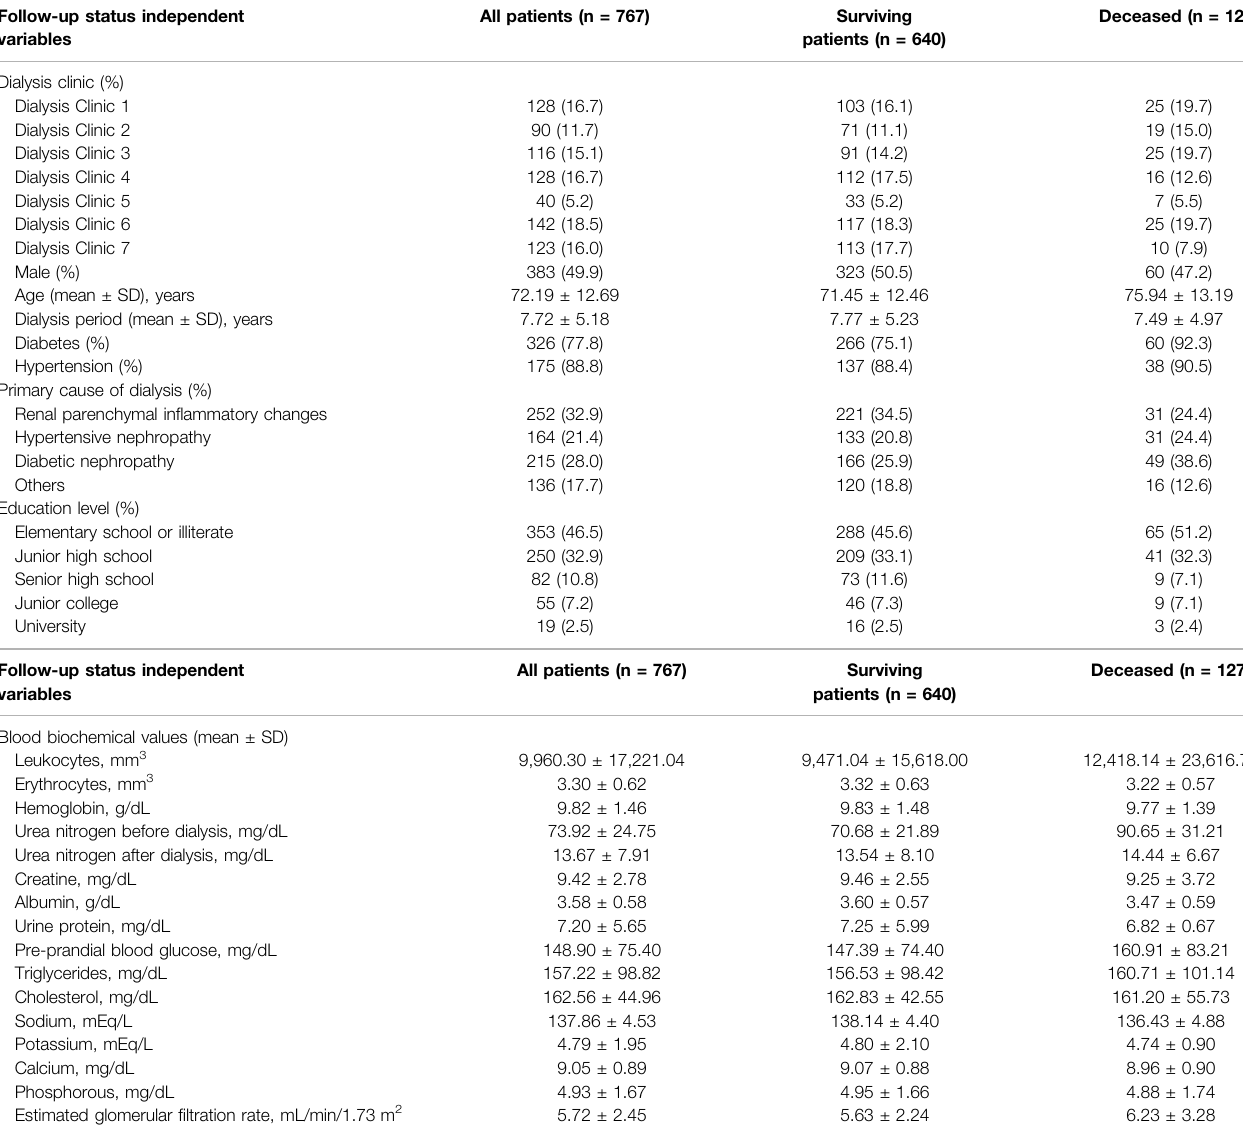
TABLE 1 | General information of the followed-up